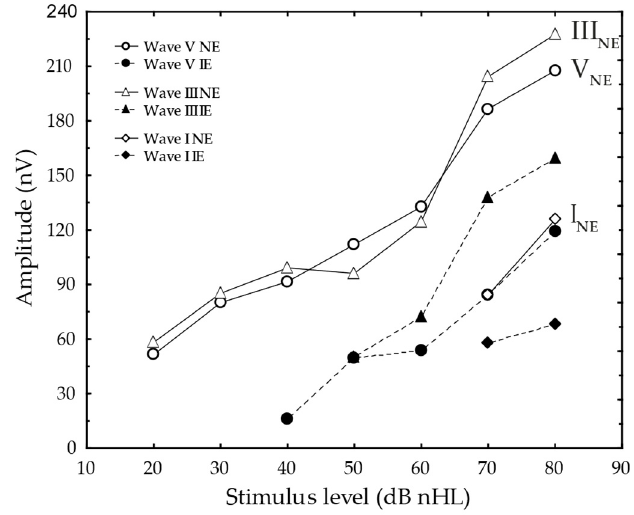
Figure 3. Mean auditory brainstem response amplitude as a function of stimulus level (dB nHL) for wave V (circles), wave III (triangles) and wave I (rhombi) demonstrates parallel shifted I/O functions, when comparing the NE (open) with the IE (filled). The n s = 20, 15, 16, 13, 9, 10, and 9 for Wave V in the NE for 20, 30, 40, 50, 60, 70, and 80 dB nHL, respectively, whereas n s = 6, 10, 9, 12, and 11 in the IE for 40, 50, 60, 70, and 80 dB nHL, respectively. For wave III the n s = 11, 12, 14, 11, 9, 20, and 9 in the NE for 20, 30, 40, 50, 60, 70, and 80 dB nHL, respectively, whereas n s = 7, 5, 11, and 10 in the IE for 50, 60, 70, and 80 dB nHL, respectively. The wave I ns = 8 and 7 for the IE and ns = 17 and 8 for the NE at 70 and 80 dB nHL, respectively.